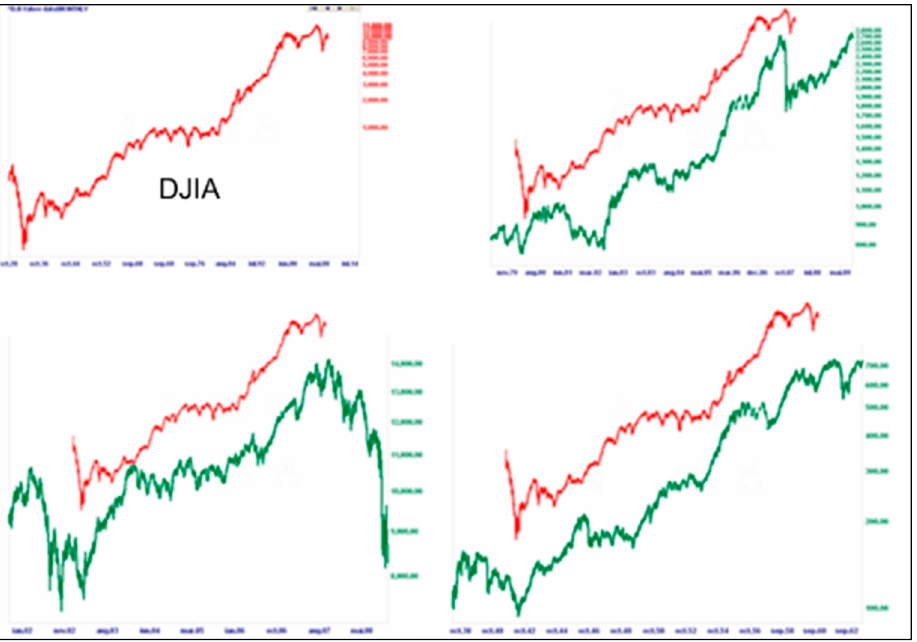
Figure 1. Fractal structures empirically found on the DJIA course. Source: Authors’ processing is based on data available on Incredible Charts Pro.